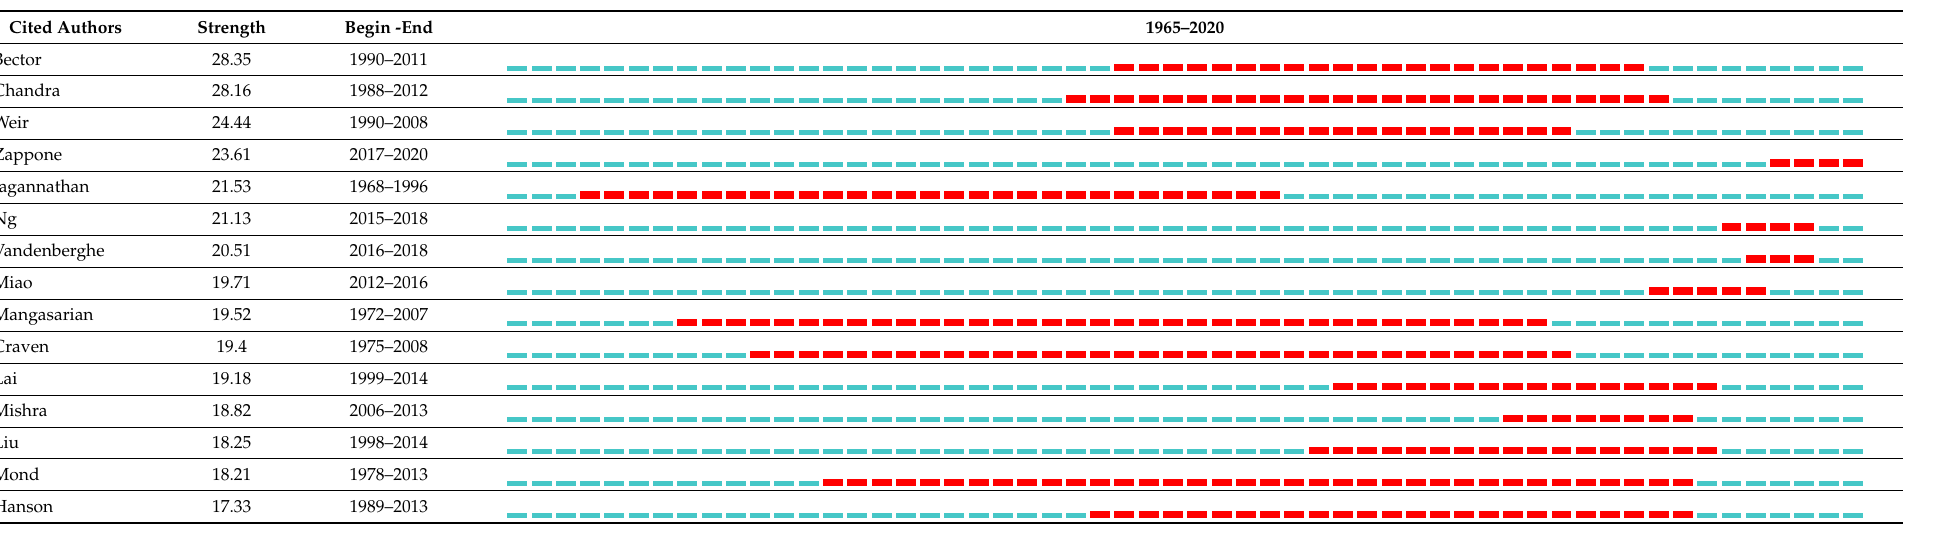
Table 6. Top 15 cited authors with the strongest citation bursts. The last column includes blue and red lines where the blue line portrays the beginning and end of a cited author through the years and the red line illustrates the period of a cited authors burst.